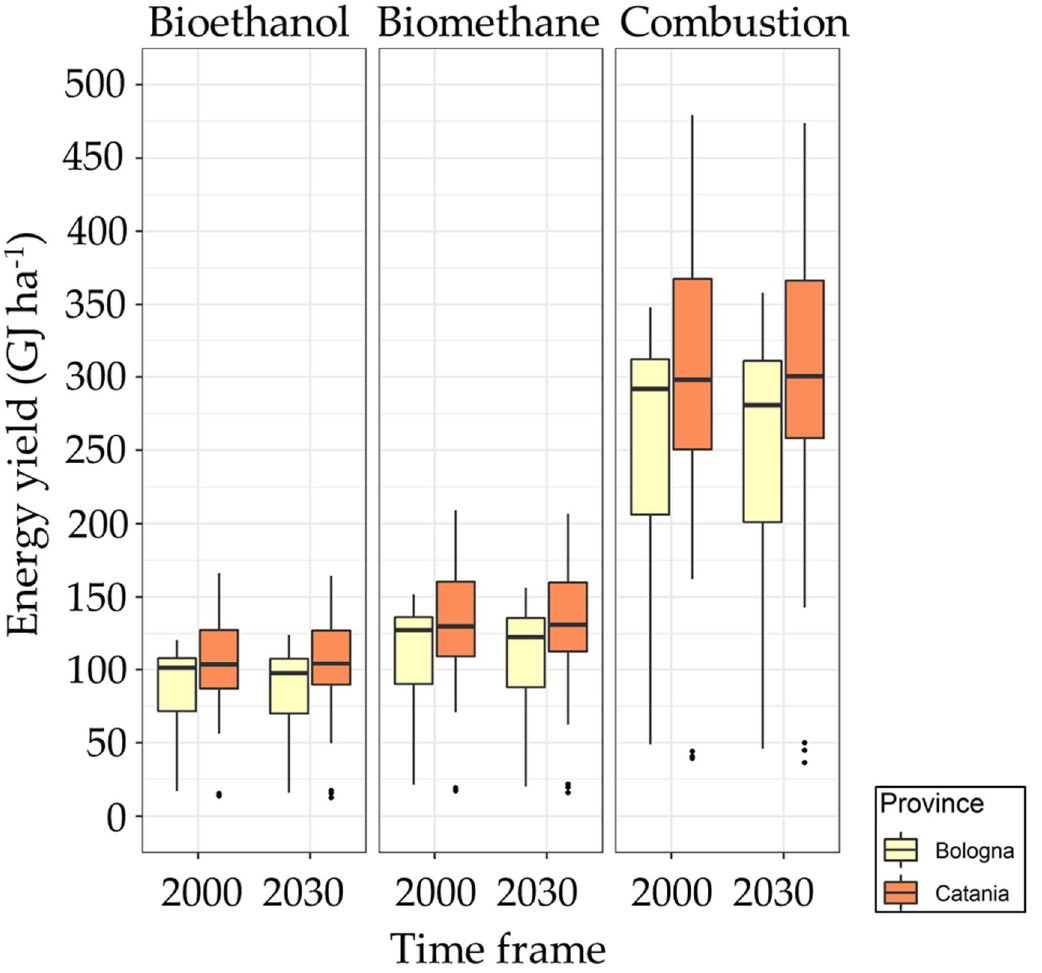
Figure 5. Boxplots of energy yields (GJ ha − 1 ) obtained from simulated (i) bioethanol, (ii) biomethane, and (iii) combustible solid data for the baseline (2000) and 2030 in the marginal areas of Bologna and Catania provinces. Each box derives from the values simulated for the combination year (30) × simulation unit (1226 in Bologna; 4765 in Catania). Black dots represent outliers values.